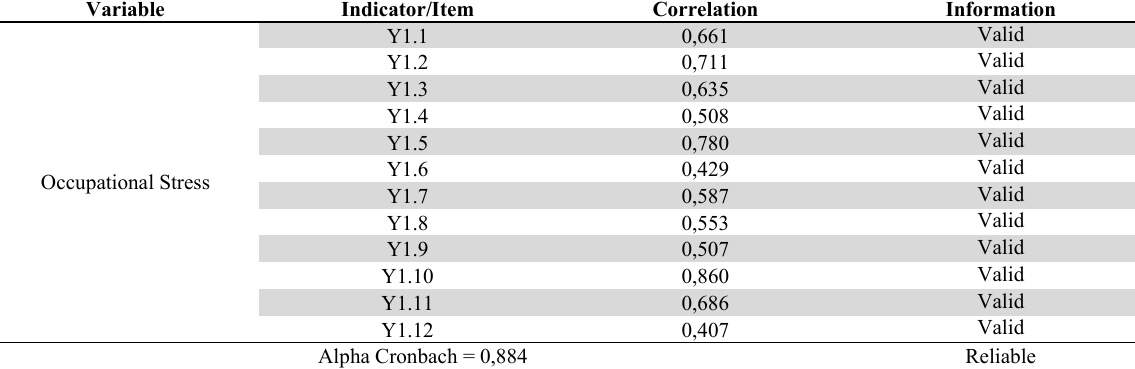
Validity and Reliability Test for Occupational Stress Variable Variable